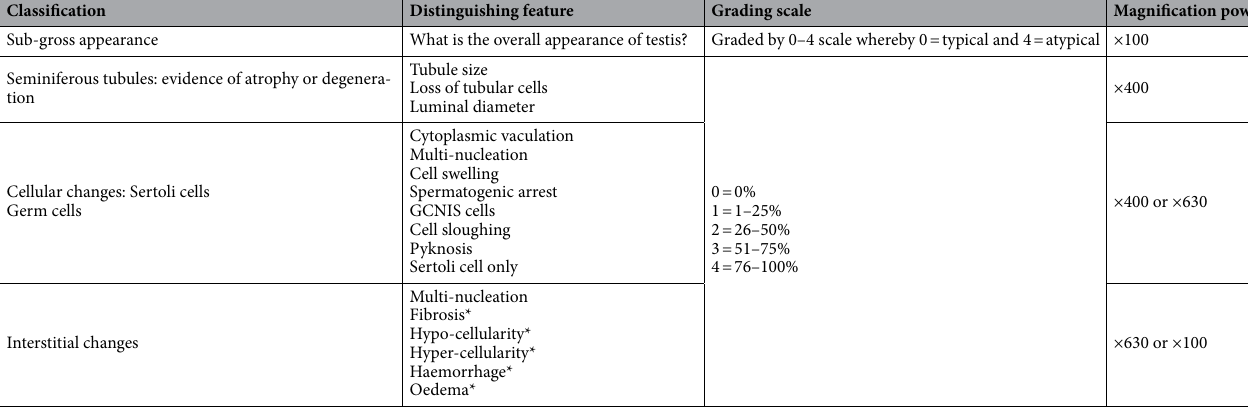
Table 2. Evaluated testicular histopathological parameters. The parameters were scored by a five-point scale and grading scale percentages relate to proportion of entire testis. Asterisk (*) denotes features assessed qualitatively and by general comment